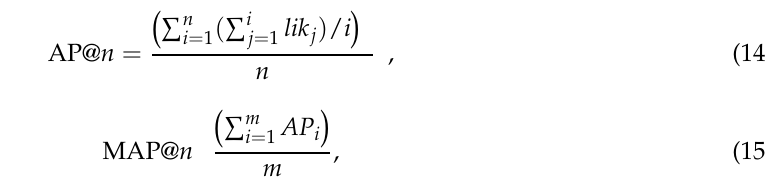
Figure 6. The impact of topic number.